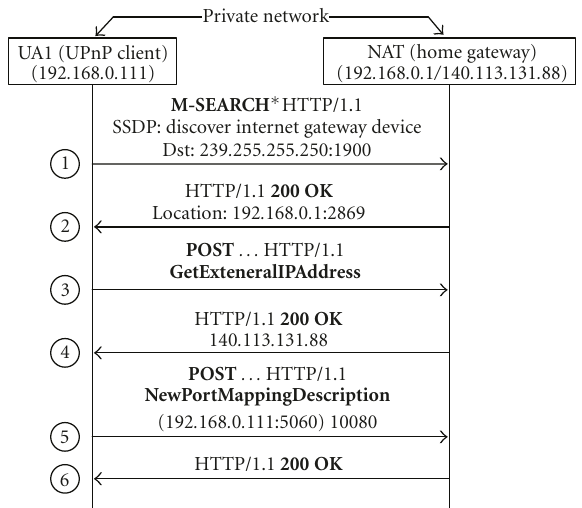
Figure 3: UPnP message flow for establishing IP information mapping.